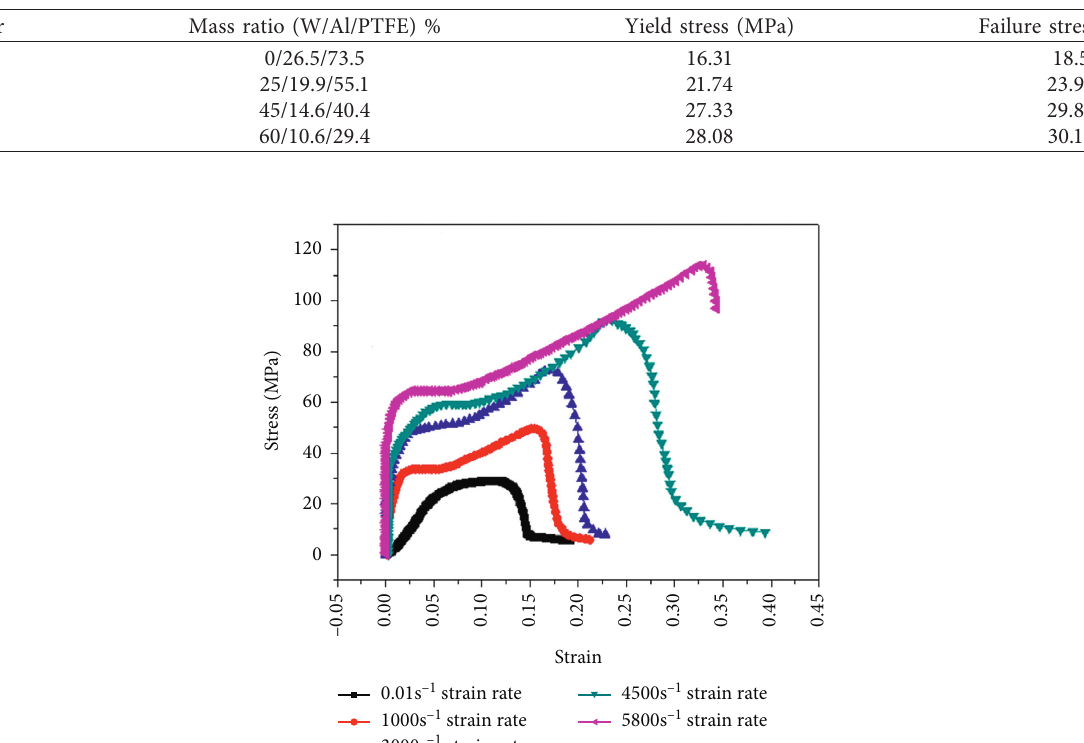
Table 2: Quasistatic compressive mechanical properties of the Al/PTFE/W materials.